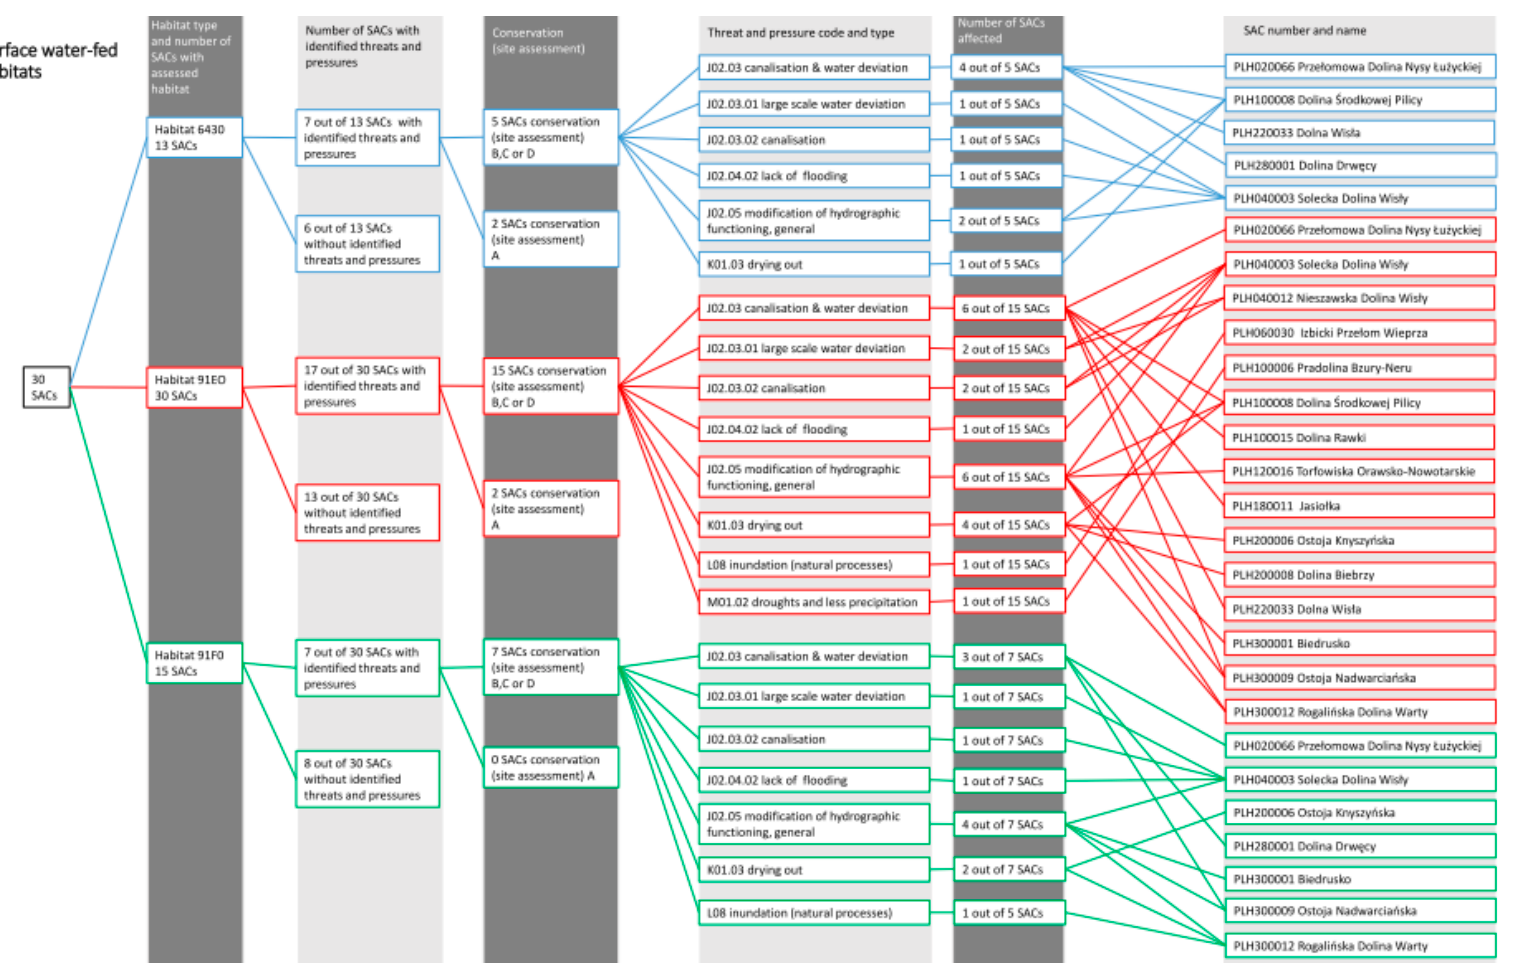
Figure A1. Analysis scheme for identified threats, pressures, and conservation status of surface water-fed habitats within SACs.